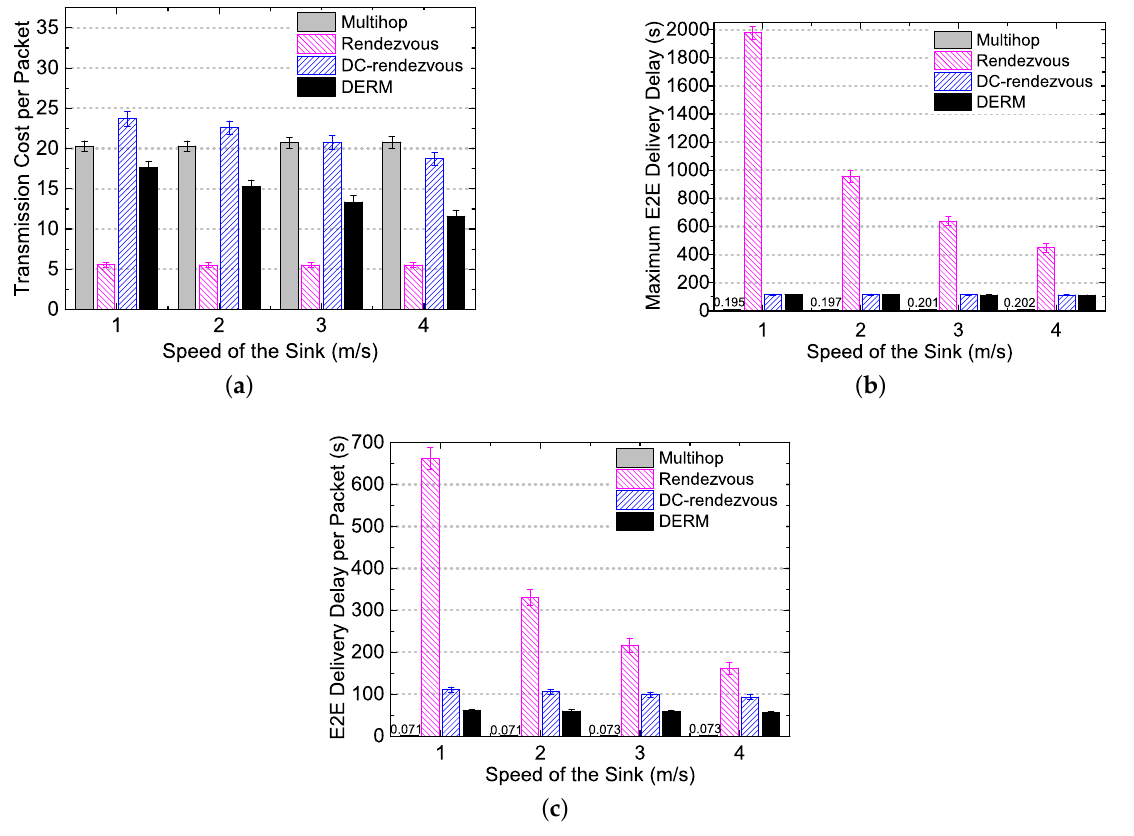
Figure 8. Performance overview under different sink speeds in ideal movement scenarios ( D s = 120 s). ( a ) transmission cost per packet; ( b ) maximum end-to-end delivery delay; ( c ) end-to-end delivery delay per